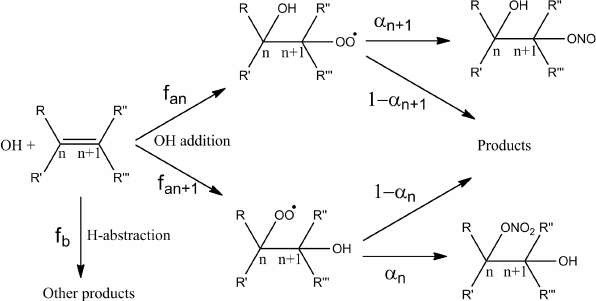
Figure 41. Reaction pathways of alkenes with OH. OH oxidation Figure 1. Reaction pathways of alkenes with OH. OH oxidation with alkenes follows two pathways: OH addition ( f n and f n +1 ) with alkenes follows two pathways: OH addition ( f n and f n + 1 ) l (cid:80) l and H-abstraction ( f ab , where f ab = f ab n ). f a + f ab ) = 1. Sub- P f ab n ). f a + f ab ) = 1. Sub- and H-abstraction ( f ab , where f ab = n =1 scripts indicate the carbon number at which either OH addition or n = 1 abstraction occurs. For alkenes studied in this work at room temper- scripts indicate the carbon number at which either OH addition or ature, the sum of f a n and f a n +1 is much greater than f ab . See text abstraction occurs. For alkenes studied in this work at room temper- for further discussion of estimations for f ab . ature, the sum of f a n and f a n + 1 is much greater than f ab . See text for further discussion of estimations for f ab